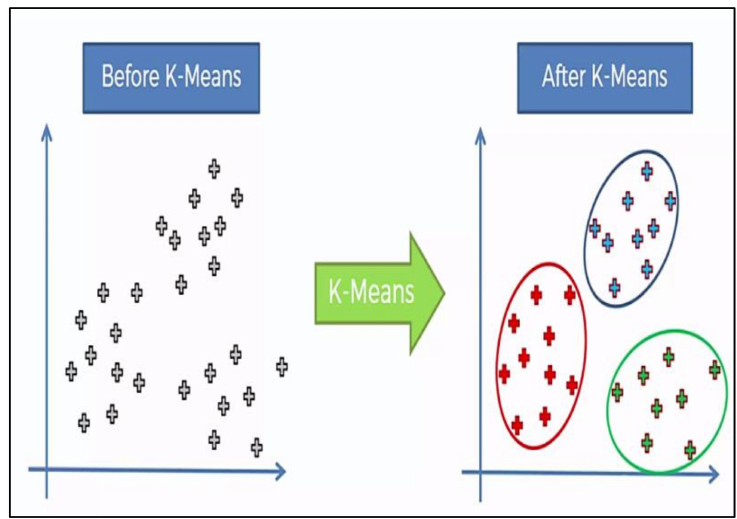
Figure 12. The k-means algorithm.